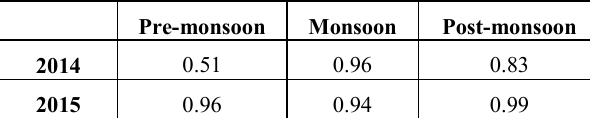
Table 2 Correlation coefficient between GPM-IMERG Early and